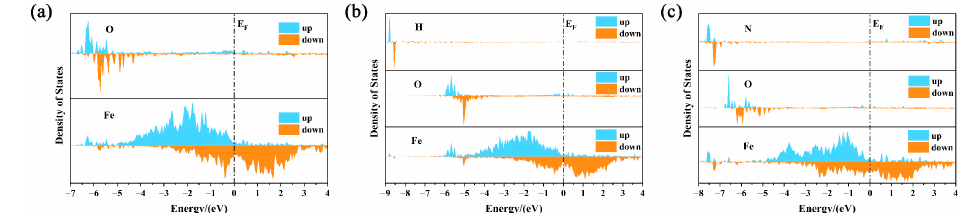
Figure 5. DOS of pure γ -Fe and H/N-containing austenite adsorbed with atomic oxygen. ( a – c ) are the DOS of pure γ -Fe and H/N-containing austenite adsorbed with atomic oxygen, respectively.